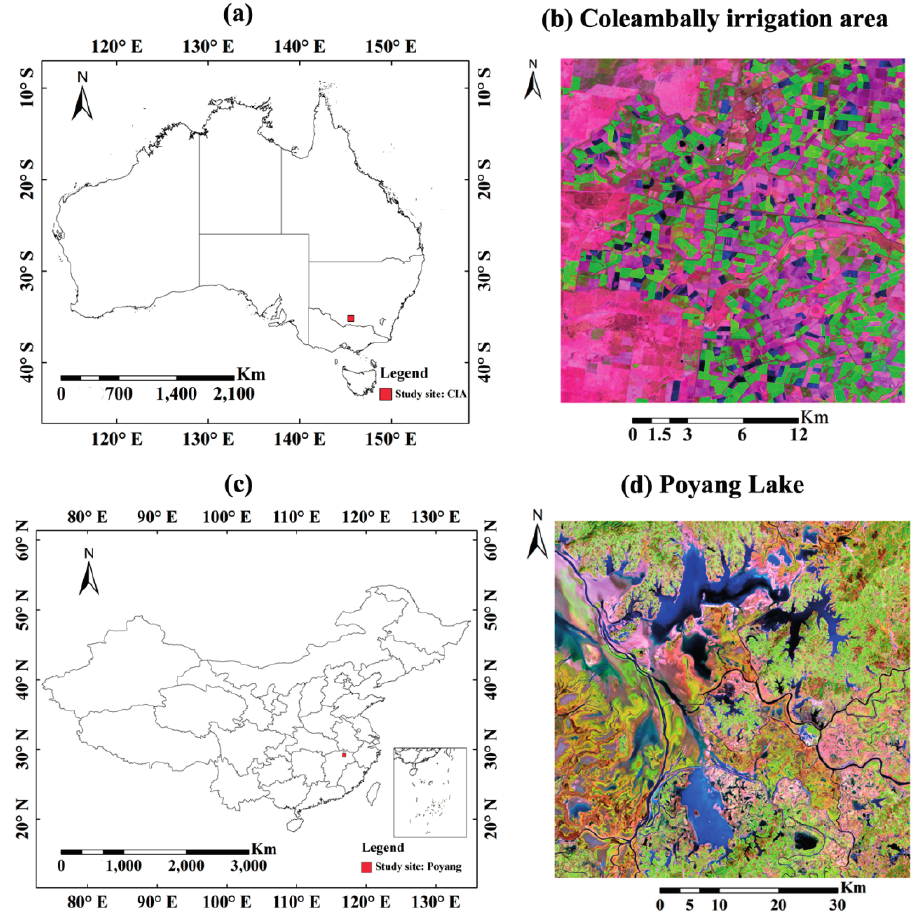
Figure 1. Location of the two study sites. ( a ) A map of Australia with the CIA site labeled in a red square; ( b ) The RGB composite of the Landsat image with B5, B4, and B3 acquired on 8 October 2001 for the CIA; ( c ) A map of China with the Poyang Lake site labeled in a red square; ( d ) The RGB composite of the Landsat image with B5, B4, and B3 acquired on 15 February 2004 for the Poyang Lake